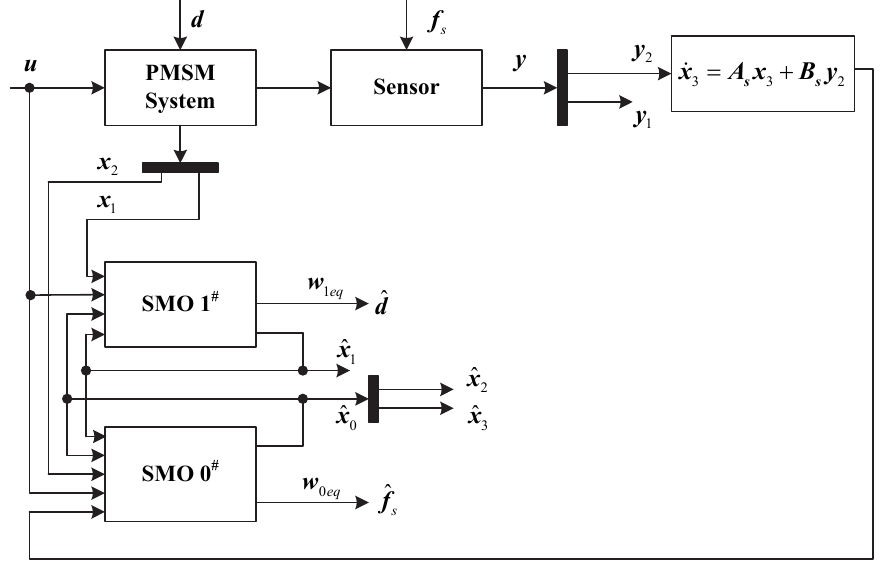
Figure 1. Schematic of the sensor fault reconstruction and unknown input disturbances estimation by